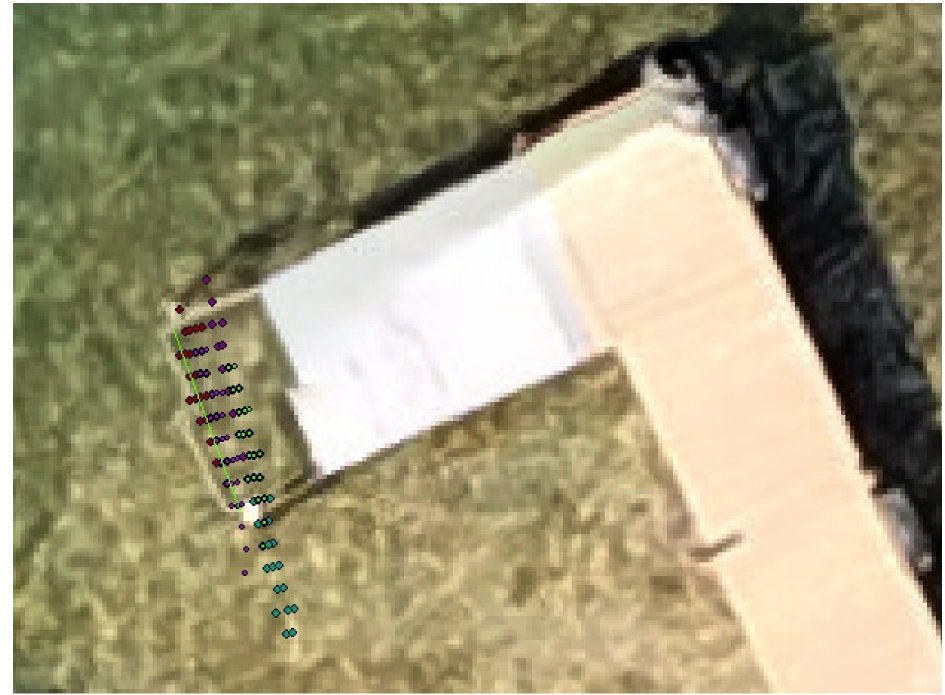
Figure 11. Photogrammetric and radar picture of a metal structure on a wooden jetty used for accuracy determination.